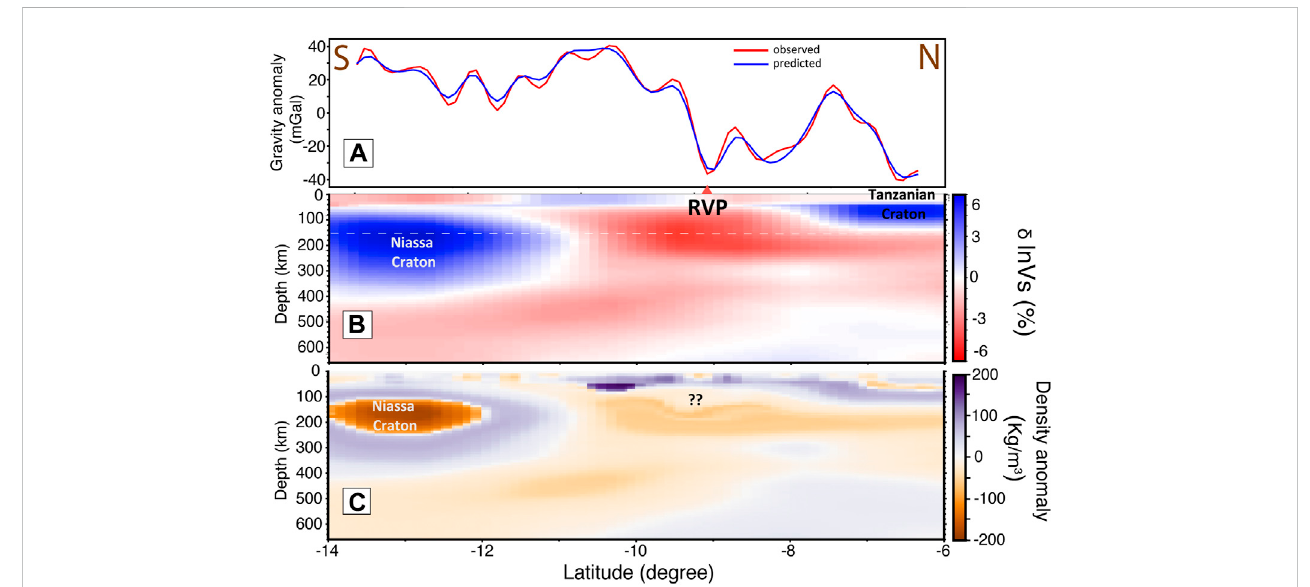
FIGURE 5 Pro fi le across the Rungwe Volcanic Province (RVP) and the Niassa Craton (pro fi le N-S; Figure 3A) showing (A) fi t between observed (red) and forward calculated gravity (blue). (B) The shear-wave velocity perturbation from Emry et al. (2019) along pro fi le N-S used as the reference model for the constrained inversion. The lowest shear-wave velocity occurs beneath the RVP at depths of ~33 – 300 km. (C) Pro fi le showing the derived density anomaly (pro fi le N-S; Figure 4B). Beneath theRVP, the lowest density anomaly(~-50 kg/m 3 )occurs at depths between 200 and 250 km. At shallowerdepths beneath theRVP corresponding to the lithospheric mantle, the density anomaly is more positive (??) probably due to compositional heterogeneity.